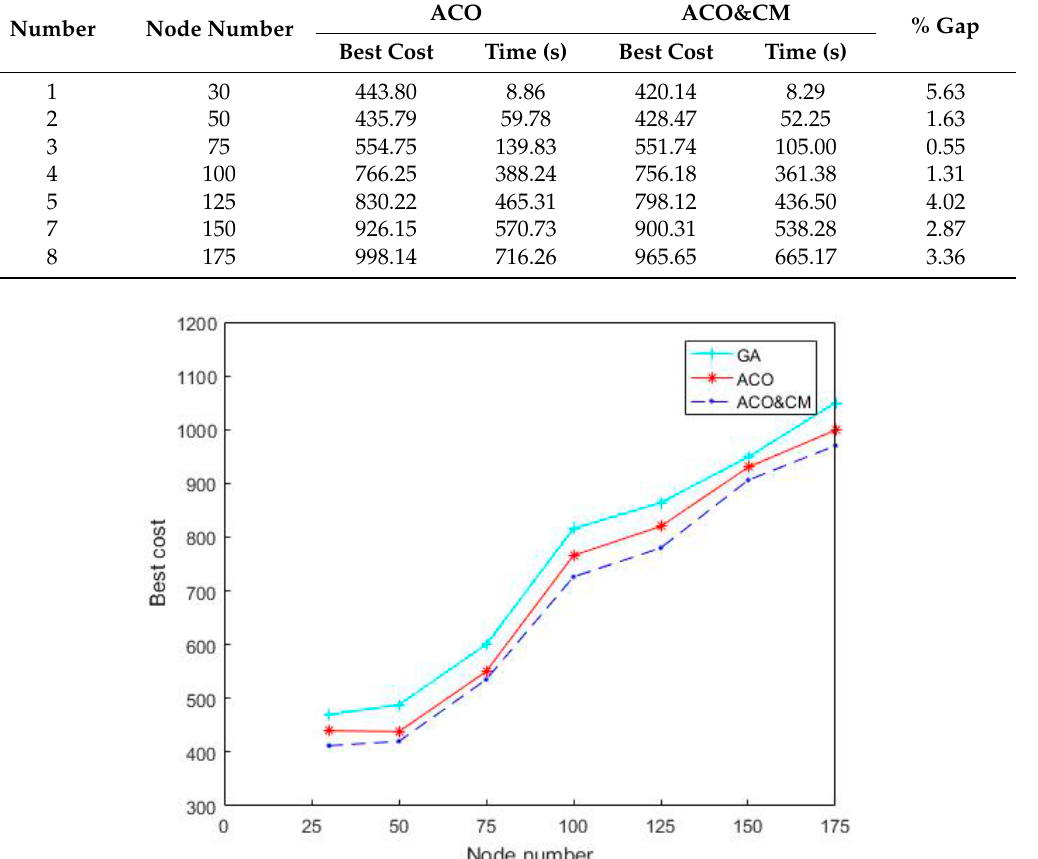
Table 1. The comparison of ACO with ACO&CM Algorithm.